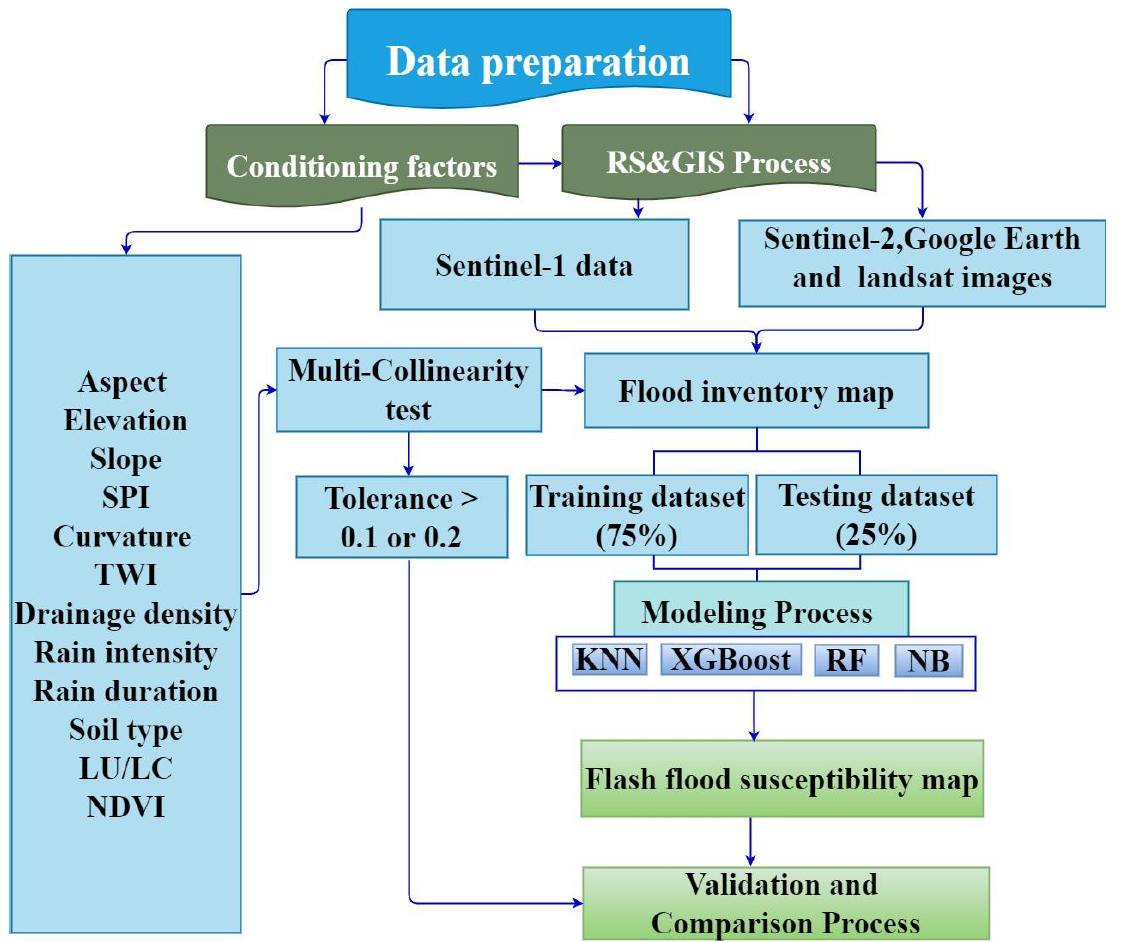
Figure 7. The flowchart adopted for this study.